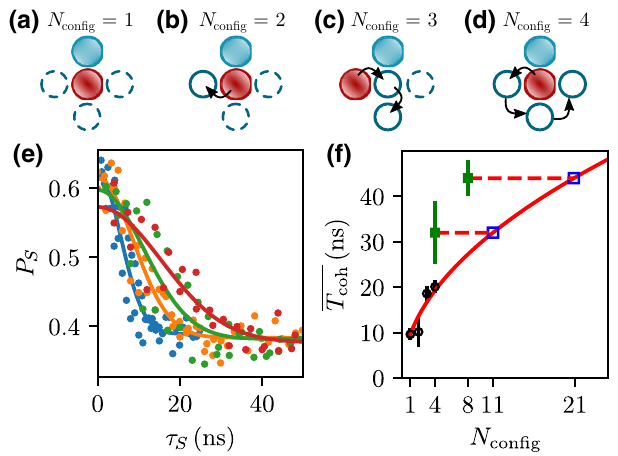
FIG. 3. Quasistatic electron spin coherence. (a)–(d) Schemat- ics of the different electron spin displacement sequences inside the 2D array of five QDs employed to probe the electron spin coherence shown in (e). (e) The singlet probability plotted as a function of the total electron-separation time τ S spent in one [ T - C , blue, (a)], two [ T - C and T - L , orange, (b)], three [ T - L , T - C , and T - B , green, (c)], and four [ T - C , T - L , T - B , and T - R , red, (d)] different charge configurations. The two electrons are ini- tialized in the singlet state in the C dot. Then, one electron is first transferred to T and the second electron visits each other dot only once over an equal time period of τ R . As a conse- quence, for the different sequences, the second electron spends a total separation time τ S = 1 × τ R in C , τ S = 2 × τ R in C and L , τ S = 3 × τ R in L , C , and B , or τ S = 4 × τ R in C , L , B , and R , where τ R is in integer value of the arbitrary waveform generator (AWG) clock period. The data are fitted with Gaussian decays (solid lines) with characteristic times equal to 7.9 ± 0.6 (blue), 12.3 ± 0.7 (orange), 15.8 ± 1.5 (green), and 21.9 ± 1.6 ns (red). (f) The coherence times averaged over different possible charge configurations T coh are plotted as functions of N config (black cir- cles). The data are fitted with a square-root function (red solid (cid:2) = 9.6 ± 0.7 ns. The experimental data line) T (cid:5) N config , with T (cid:5) 2 2 of Figs. 5(c) and 5(d) are plotted as green squares ( T coh of 32 ± 7 and 44 ± 4 ns, respectively), and their projection on the square- root curve as open blue squares (equivalent N config values of 11 and 21,